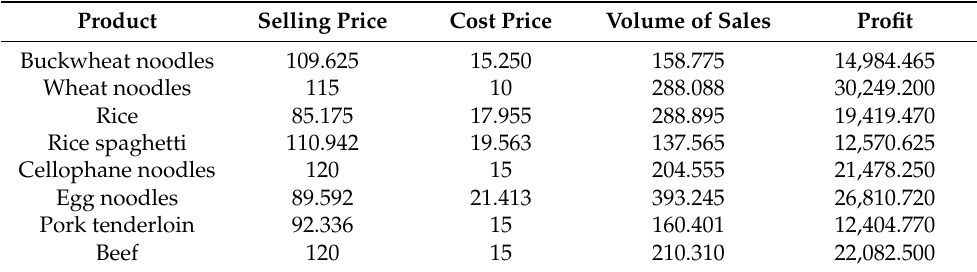
Table 4. The calculated value of factors, provided there are